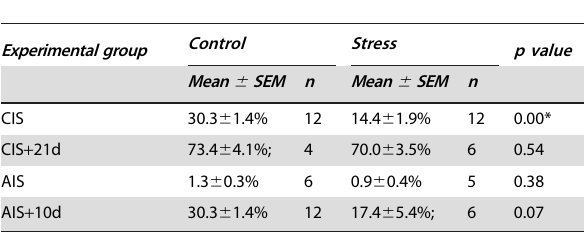
Table 1. Summary of body weight measures.